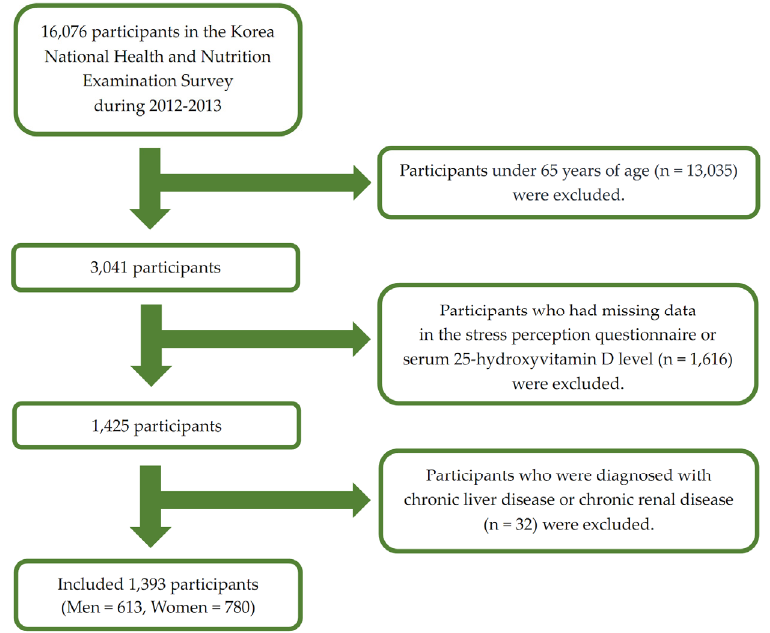
Figure 1. Flow diagram of the study participants.